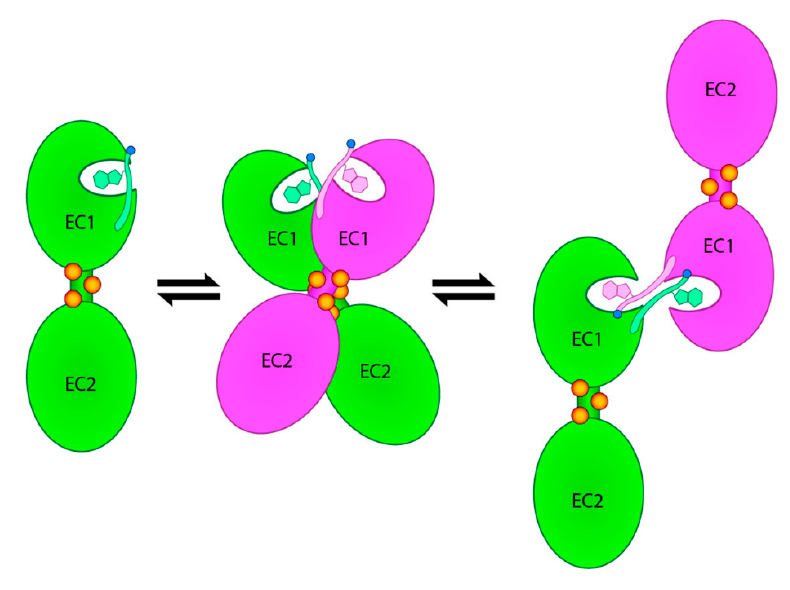
Figure 1. Schematic representation of the dynamic dimerization mechanism that leads from monomeric cadherin (left) to the strand-swap dimer, which involves mutual insertion of the Trp2 side chain in the binding pocket of the partner molecule (right) and back. The cadherin dimerization trajectory features a crucial intermediate configuration that is referred to as the X-dimer (center). Calcium ions are shown as orange dots.